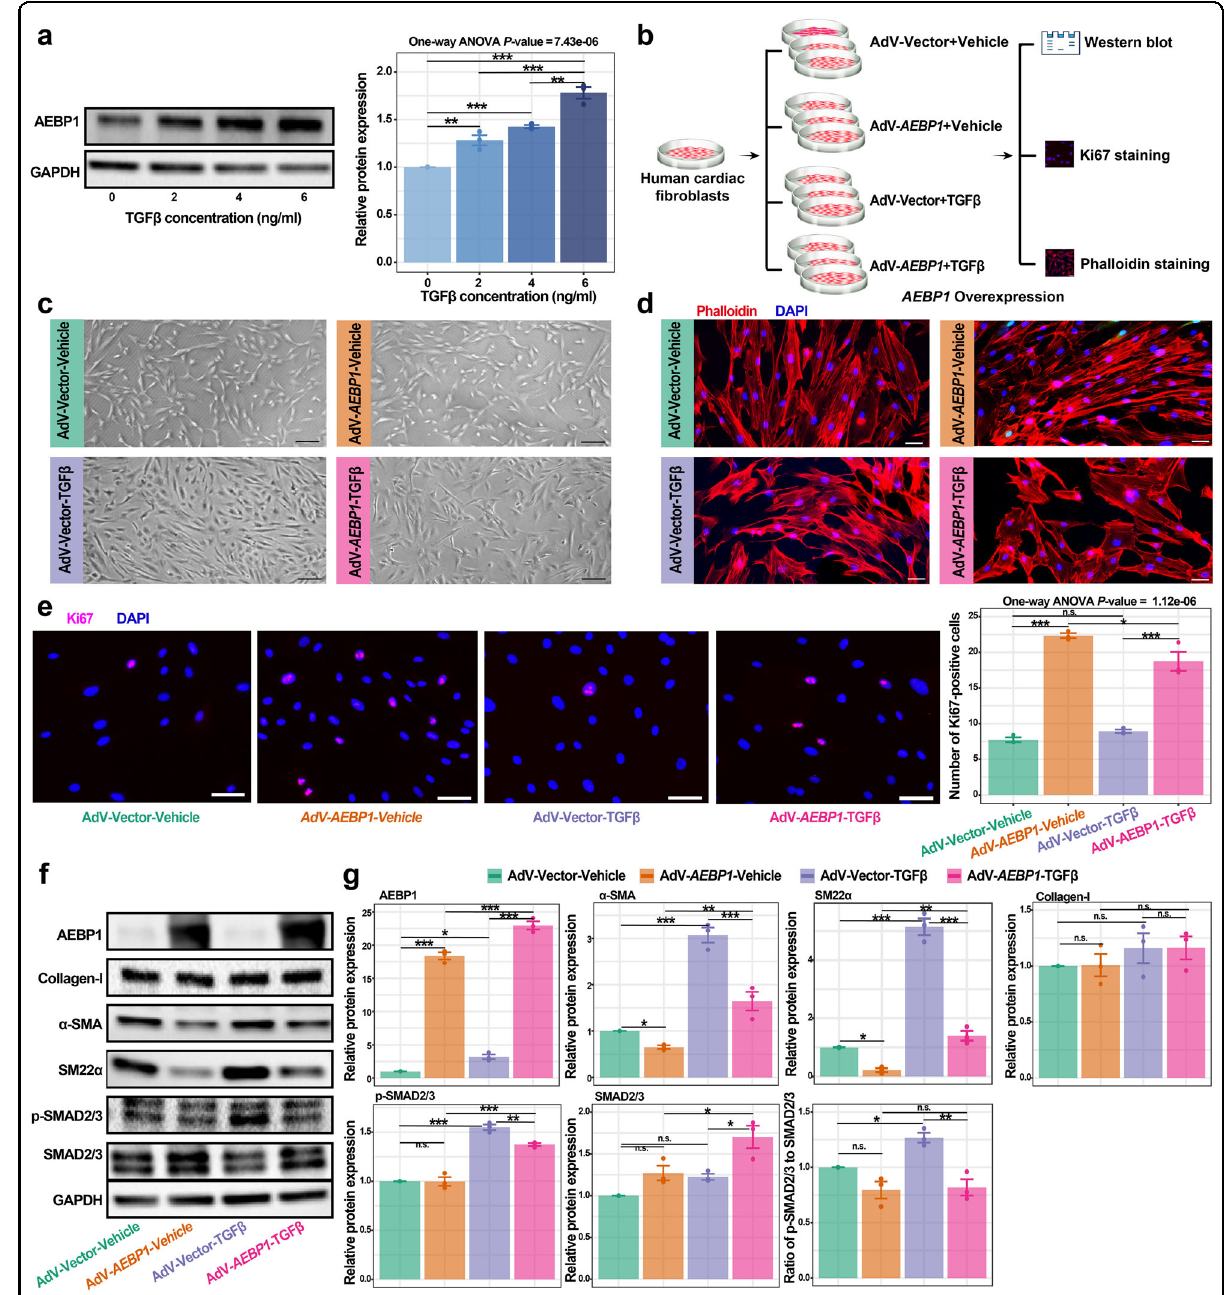
Fig. 8 In vitro overexpression of AEBP1 attenuates the activation of human cardiac fi broblasts induced by TGF β . a The protein level of AEBP1 in cultured cardiac fi broblasts was signi fi cantly increased by TGF β treatment. We chose 6 ng/mL TGF β for the following experiments. b Schematic diagram showing the experimental design and procedure of AEBP1 overexpression. AdV-Vector-Vehicle: fi broblasts transfected with adenovirus harboring empty vector and no TGF β treatment was performed; AdV- AEBP1 -Vehicle: fi broblasts transfected with adenovirus harboring AEBP1 cDNA and no TGF β treatment was performed; AdV-Vector - TGF β : fi broblasts transfected with adenovirus harboring empty vector and followed by TGF β treatment; AdV- AEBP1- TGF β : fi broblasts transfected with adenovirus harboring AEBP1 cDNA and followed by TGF β treatment. Three independent experiments were performed for each group. Normal human ventricular cardiac fi broblasts (passages 5-6) were used. c Bright- fi eld images of the cardiac fi broblasts in each group. Scale bar: 200 μ m. d Phalloidin staining of actin fi laments showing the cellular morphology of each group. Scale bar: 50 μ m. e Ki67 staining showing that AEBP1 overexpression enhanced the proliferation of cardiac fi broblasts. In the bar plot, each value represents the mean number of Ki67-positive cells across fi ve representative fi elds of view. Scale bar: 50 μ m. f Western blot assay showing the changes in protein expression of AEBP1 and representative fi broblast activation markers in each group. g Quantitative analysis of the western blot results. For bar plots, the data are presented as means ± SEM. * P < 0.05, ** P < 0.01, *** P < 0.001, n.s.: not signi fi cant, one-way ANOVA followed by Turkey post hoc